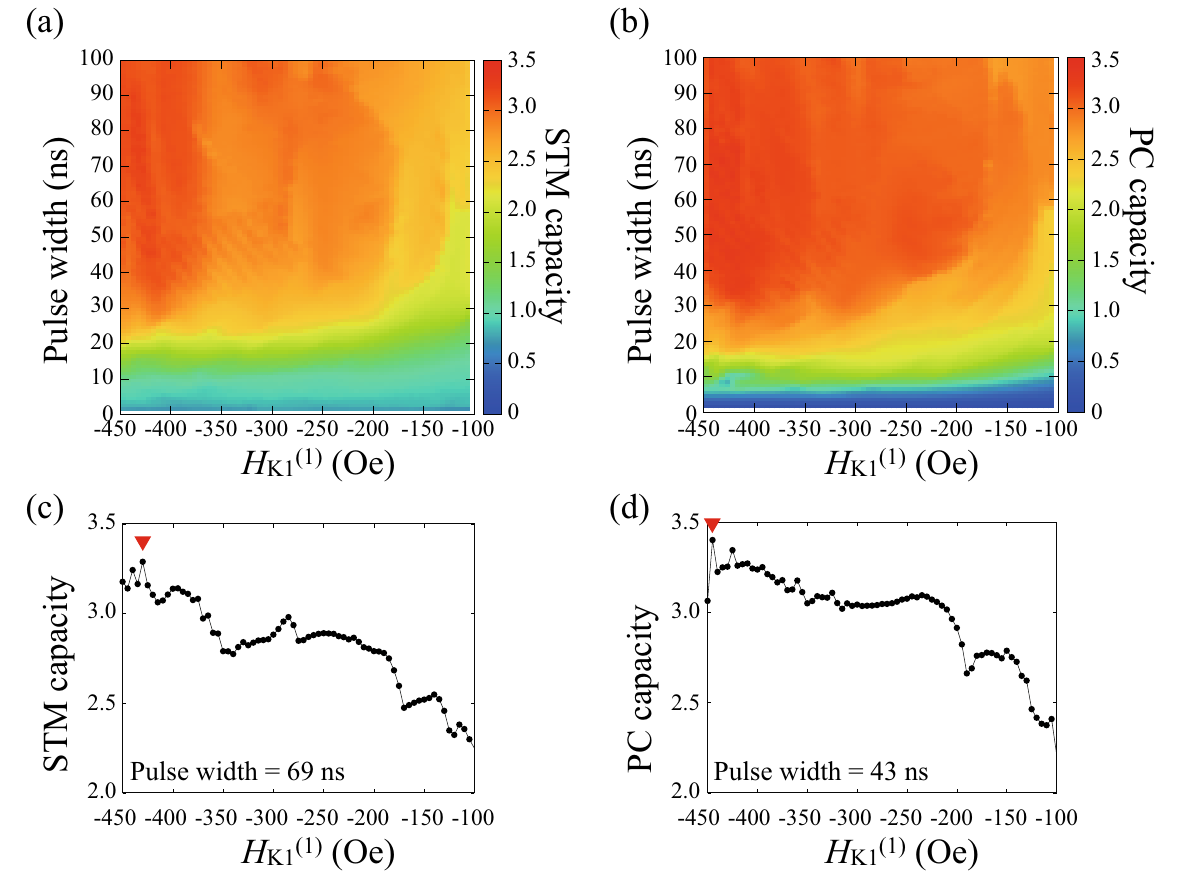
Figure 2. Dependences of ( a ) STM (linear) and ( b ) PC (nonlinear) capacities on the pulse width and the first order magnetic anisotropy field. Their highest values are indicated by the red triangles in ( c , d